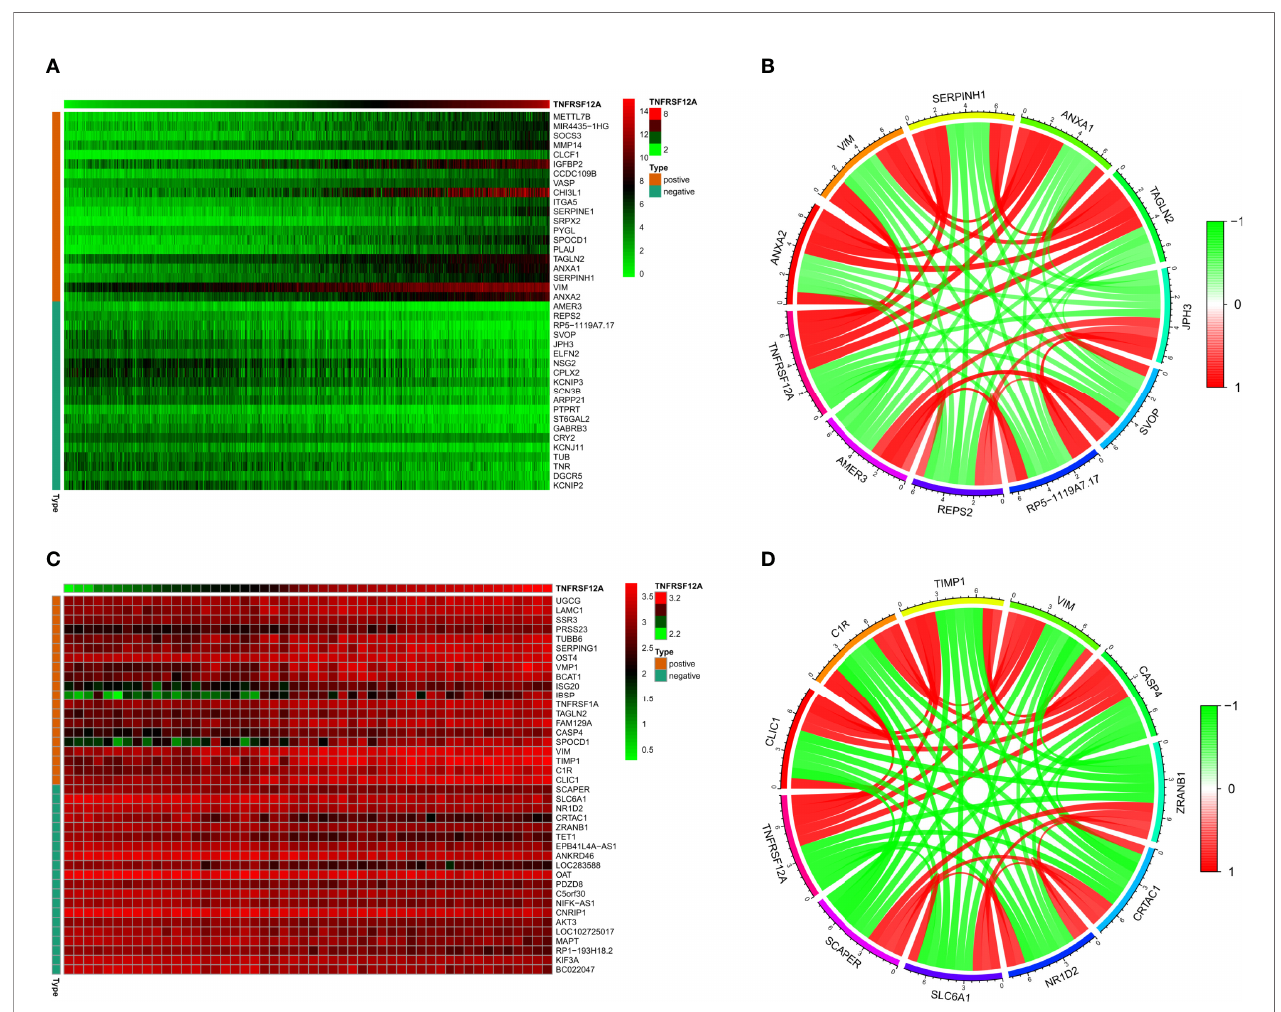
FIGURE 10 | (A) Correlation heat map of the top 20 positively and negatively correlated genes with TNFRSF12A in CGGA. (B) Correlation circles for the top 5 positively and negatively correlated genes with TNFRSF12A in CGGA. (C) Correlation heat map of the top 20 positively and negatively correlated genes with TNFRSF12A in GSE43378. (D) Correlation circles for the top 5 positively and negatively correlated genes with TNFRSF12A in